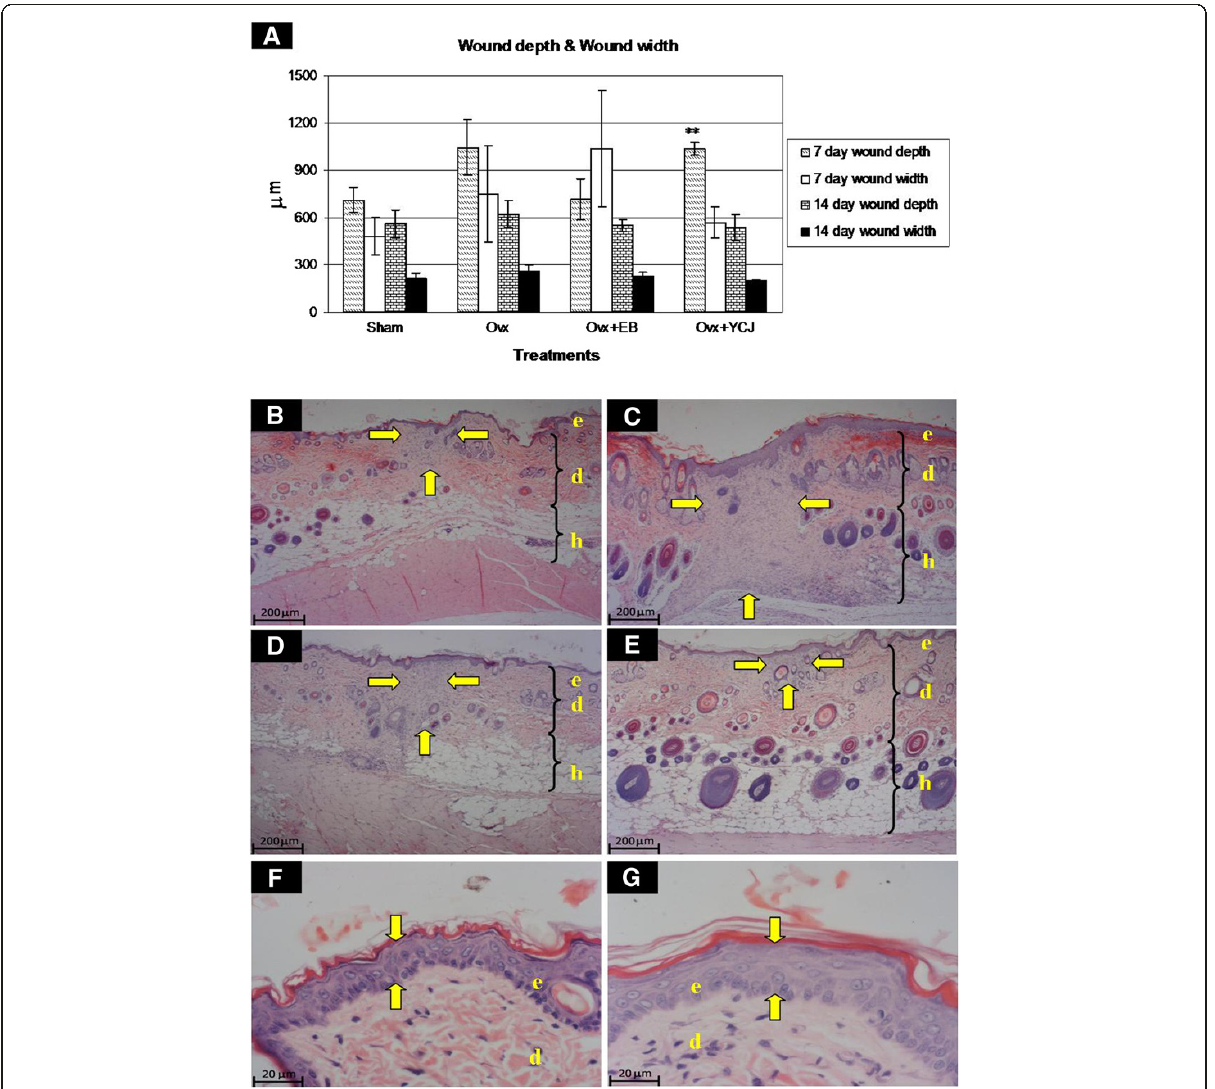
Figure 2 A. Comparison of wound depth and width in the four groups. Ovx = ovariectomized group; Ovx + EB = ovariectomized group receiving estradiol benzoate; Ovx + YCJ = ovariectomized group receiving young coconut juice. n = 6 in each group. ** P < 0.01 compared with the sham group. B - E . Sections from the dorsal skin wound areas following a 14-day-treatment period. (H&E; x4). The wound area is indicated by the yellow arrows. The wound area was the smallest in the Ovx+YCJ group (E), and the largest in the ovx group (C). Note the higher number and the bigger size of the hair follicles in the Ovx+YCJ group in both the dermis and hypodermis. B = Sham-operated group; C = Ovx group;